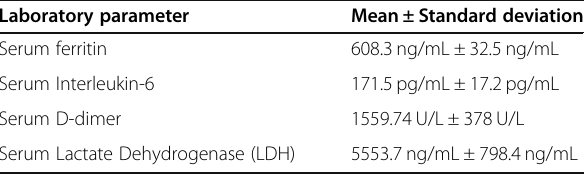
Table 4 Values of inflammatory markers ( n = 51) Laboratory